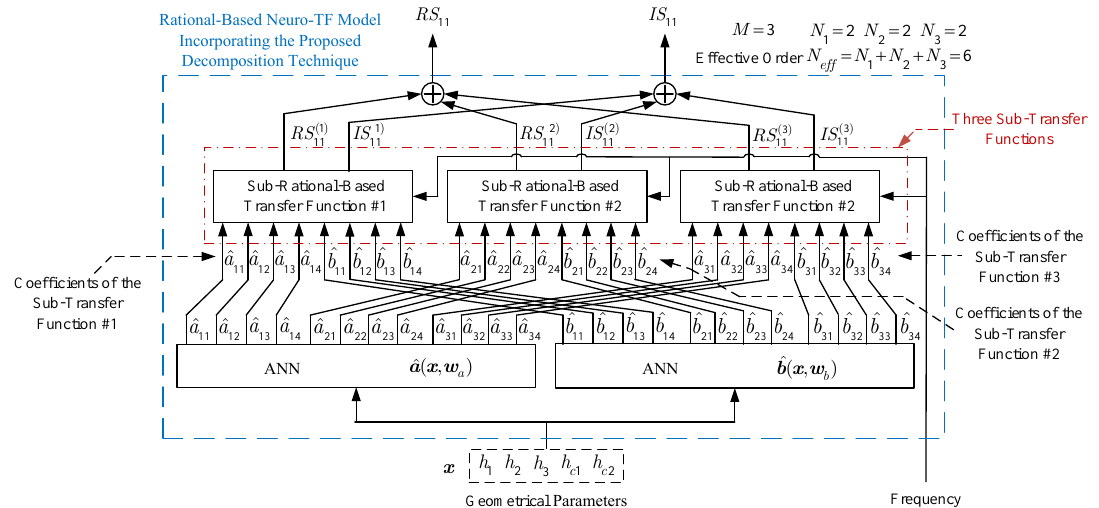
Figure 8. Structure for the proposed rational-based neuro-TF model with M = 3 of the four-order bandpass filter